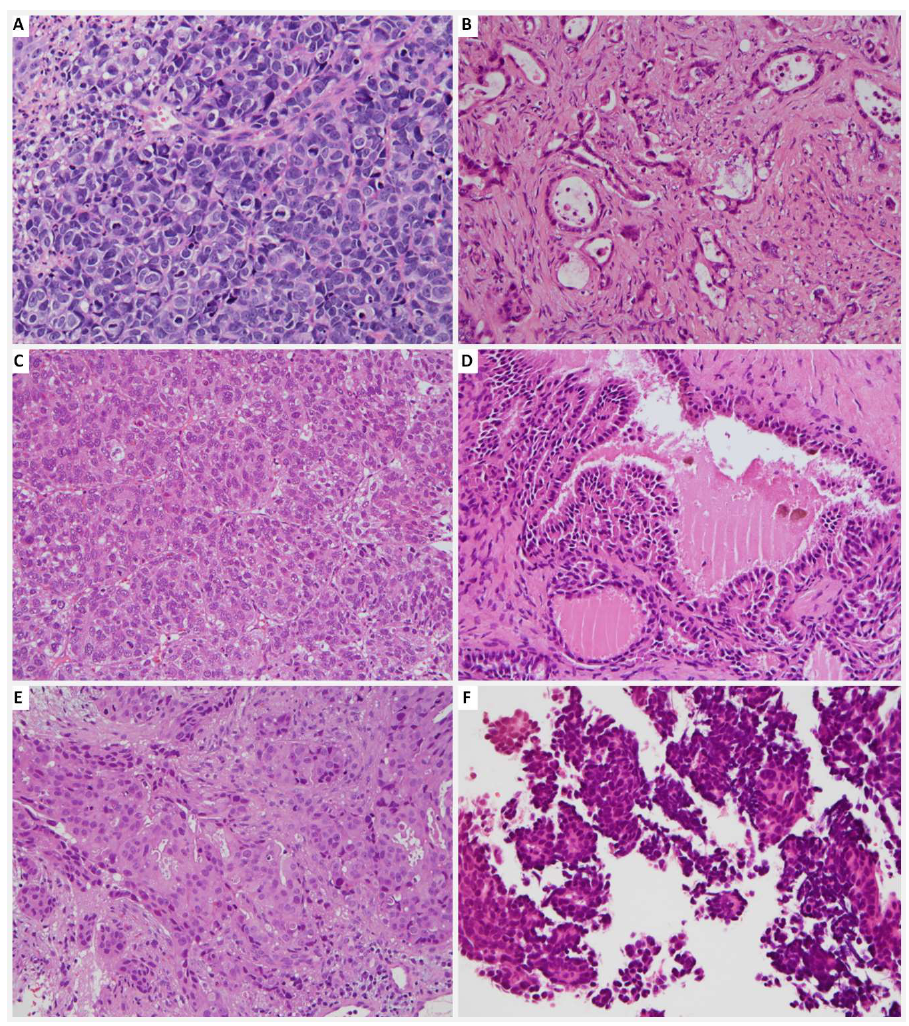
Figure 3. Pathologic images of various sinonasal metastatic cancers: ( A ) Metastatic neuroendocrine carcinoma; ( B ) Metastatic colorectal adenocarcinoma of the colon; ( C ) Metastatic hepatocellular carcinoma; ( D ) Metastatic papillary thyroid carcinoma; ( E ) Metastatic breast carcinoma; and ( F ) Metastatic pulmonary adenocarcinoma.